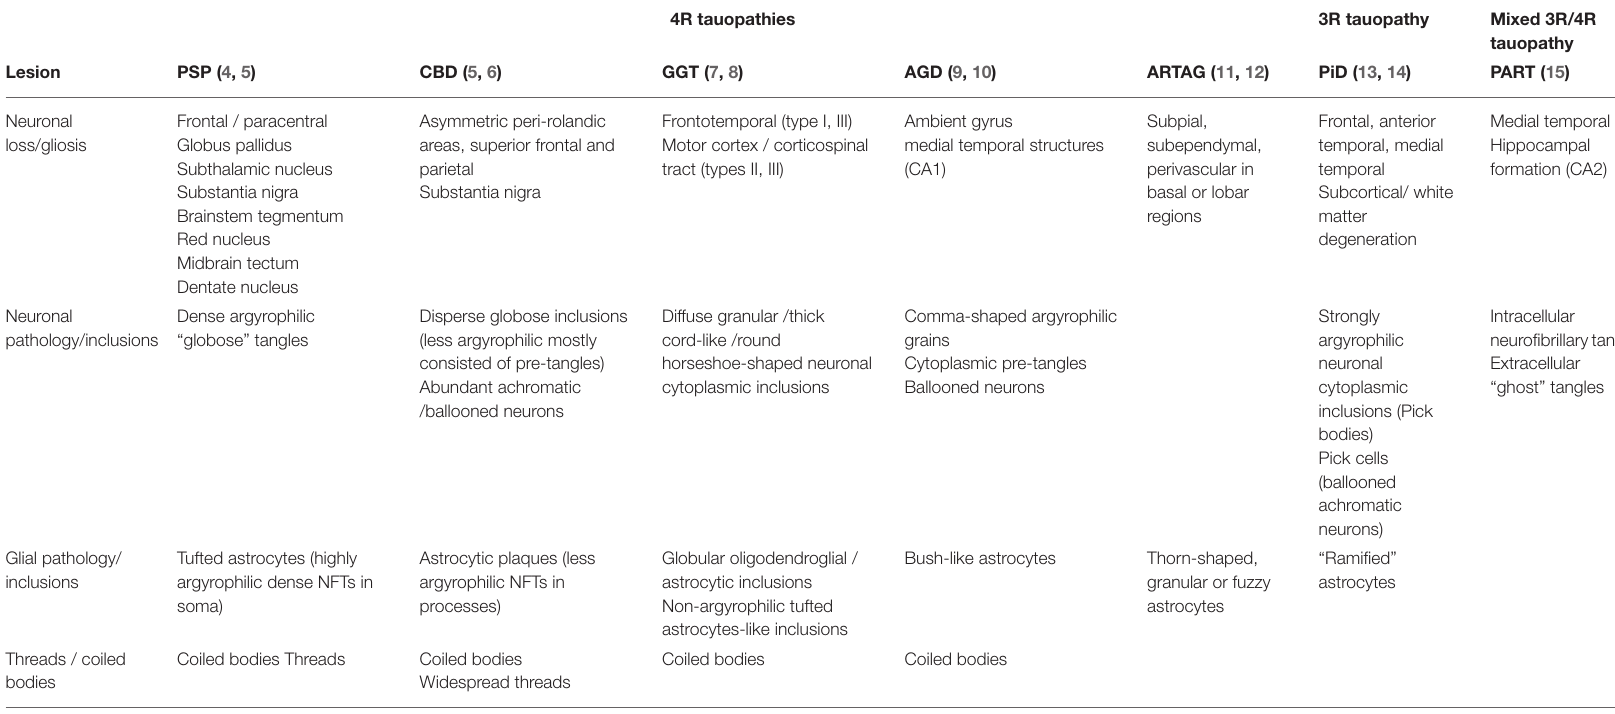
TABLE 1 | Pathologic spectrum of primary tauopathies and their defining hallmarks.